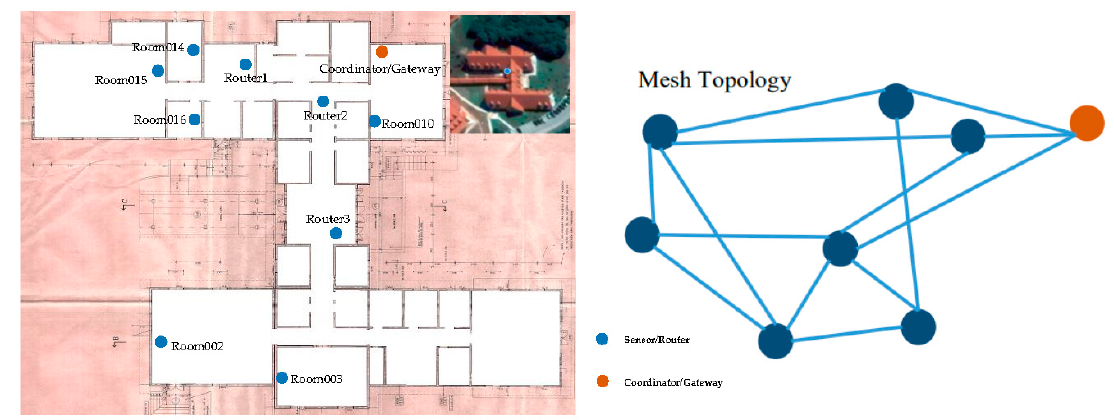
Figure 4. WSN architecture deployment at the university campus building.